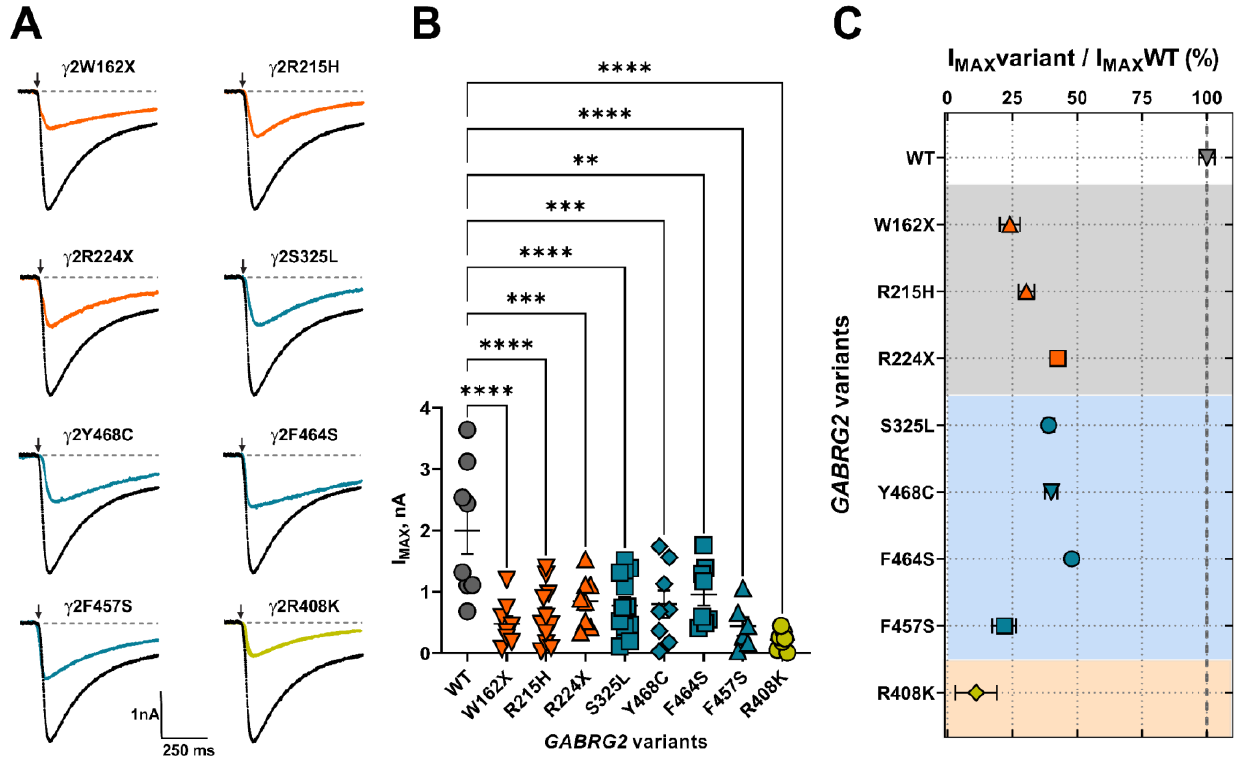
Figure 4. Mutant γ 2 subunits decreased GABA-evoked whole-cell currents. ( A ) Representative GABA current traces obtained following rapid application of 1 mM of GABA for 5 ms (arrow). The current traces from GABA A Rs containing mutant (in orange red, blue, and green) γ 2 subunits were compared to WT (black) current traces. Dashed lines represent zero currents. Activation of GABA A